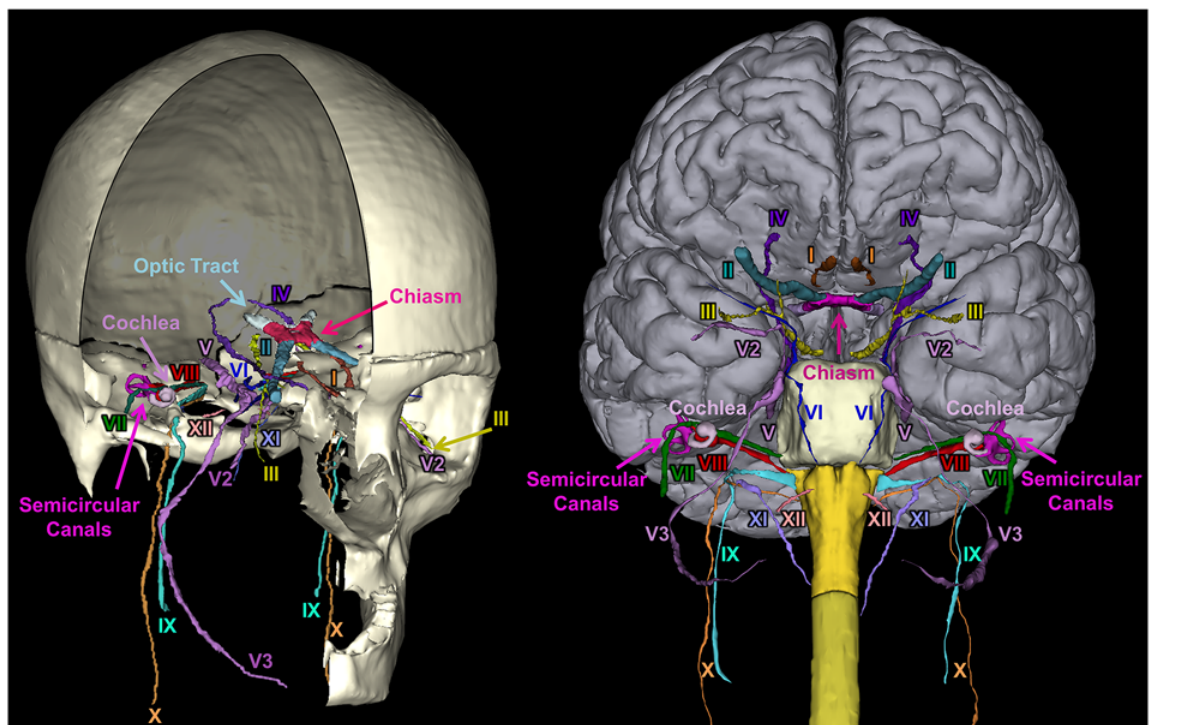
Fig 17. Segmentation of the nerves. 3D reconstruction of the 12 cranial nerves. Legend of the structures: Cranial Nerve I: Olfactory, Cranial Nerve II: Optic, Cranial Nerve III: Oculomotor, Cranial Nerve IV: Trochlear, Cranial Nerve V: Trigeminal, Cranial Nerve V2: Trigeminal Maxillary Division, Cranial Nerve